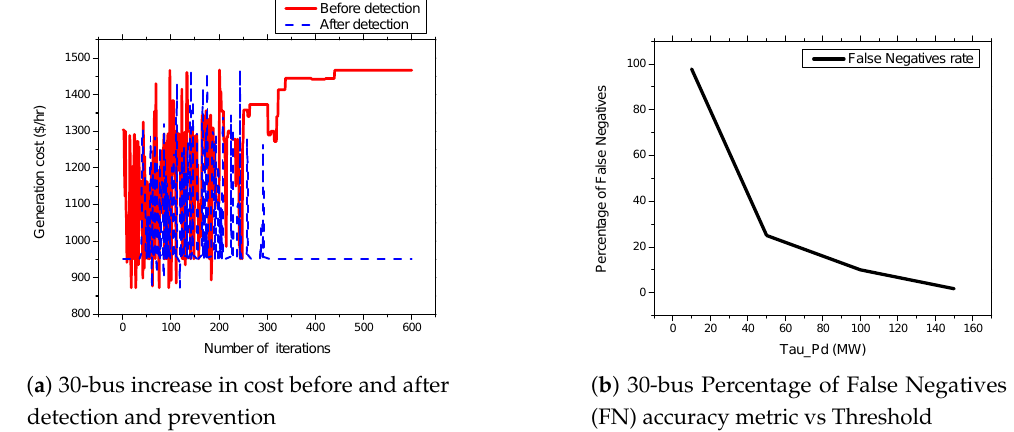
Figure 11. 30-bus systems increase in cost before and after detection and prevention and percentage of False Negatives (FN) accuracy metric vs.